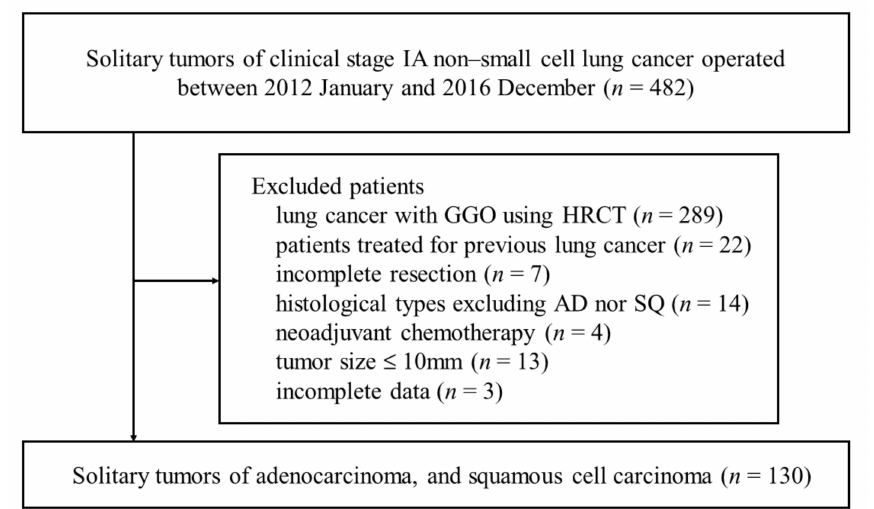
Figure 1. Patient’s flow